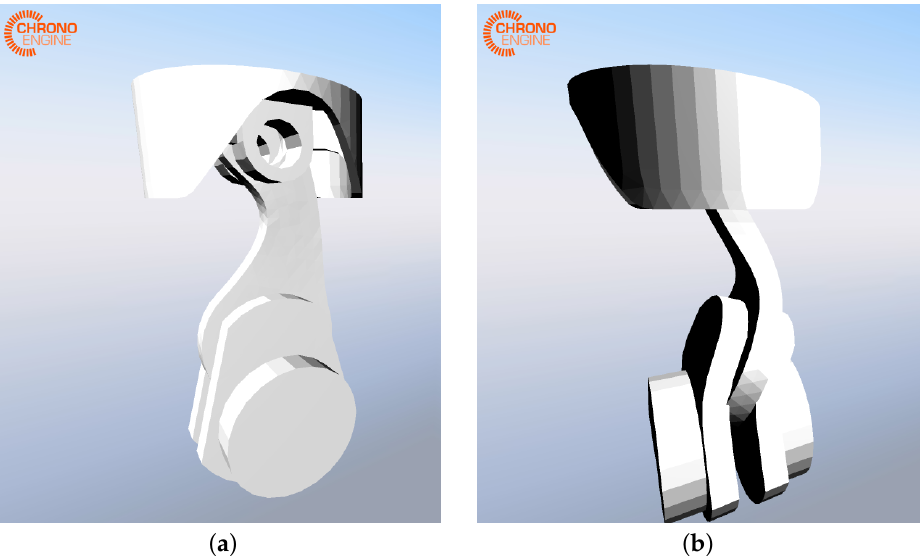
Figure 2. Benchmark for multibody flexible systems with constraints: flexible crank, rod and piston bodies with bearings. ( a ) Second Mode at 52 Hz. ( b ) Sixth Mode at 200 Hz.